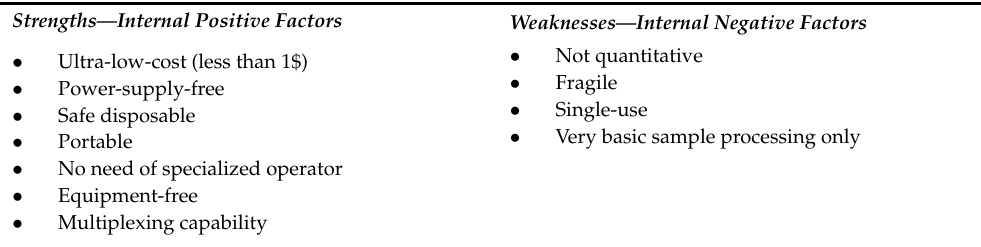
Figure 2. Patterned Paper Technology. Schematic of the technology described in Part IV to sense alanine transaminase in blood. Table 1. List of the main strengths, weaknesses, opportunities and threats for the patterned paper technology described in Part IV related to its deployment in developing countries.